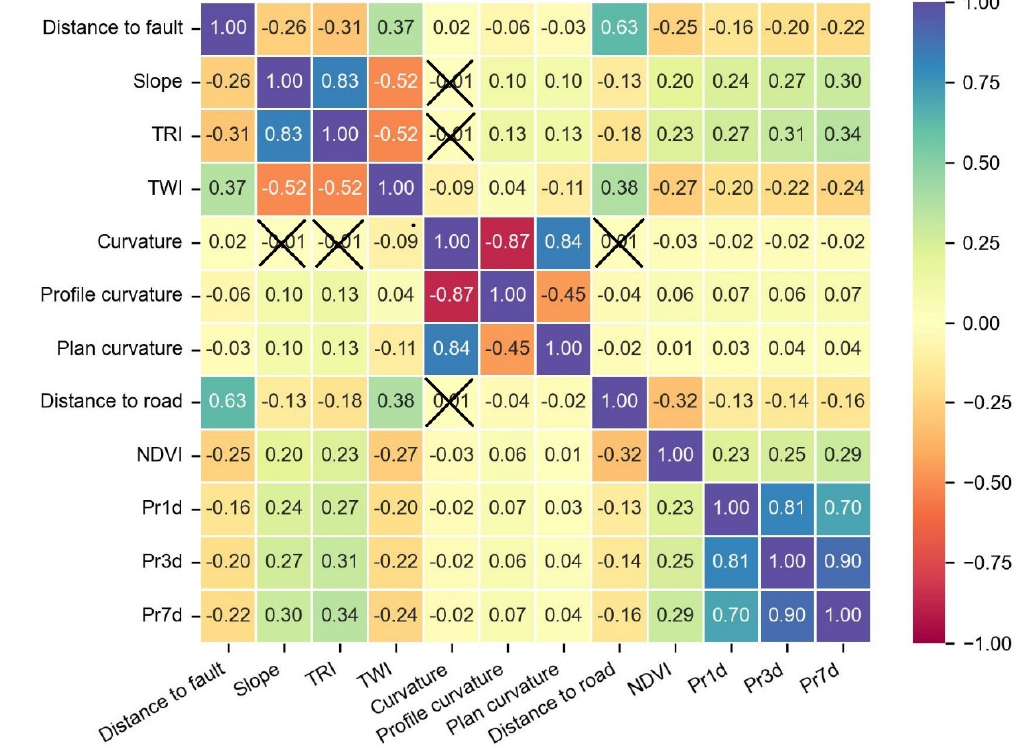
Figure 3. The Pearson correlation coefficient matrix of influencing factors ( × represents the linear relationship is not significant).